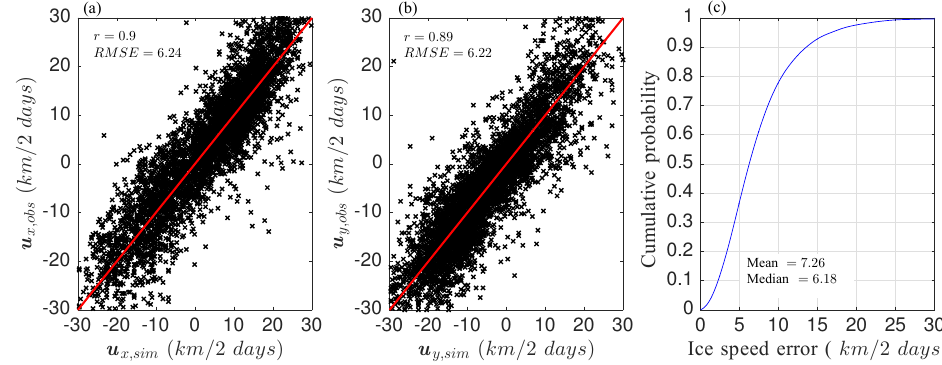
Figure 5. Scatter plots for the two components, (a) x and (b) y , of the simulated (neXtSIM, x axis) and observed drift (OSI-SAF dataset, y axis) after the air drag optimisation procedure. The cumulative distribution of the ice velocity errors is shown in panel (c)